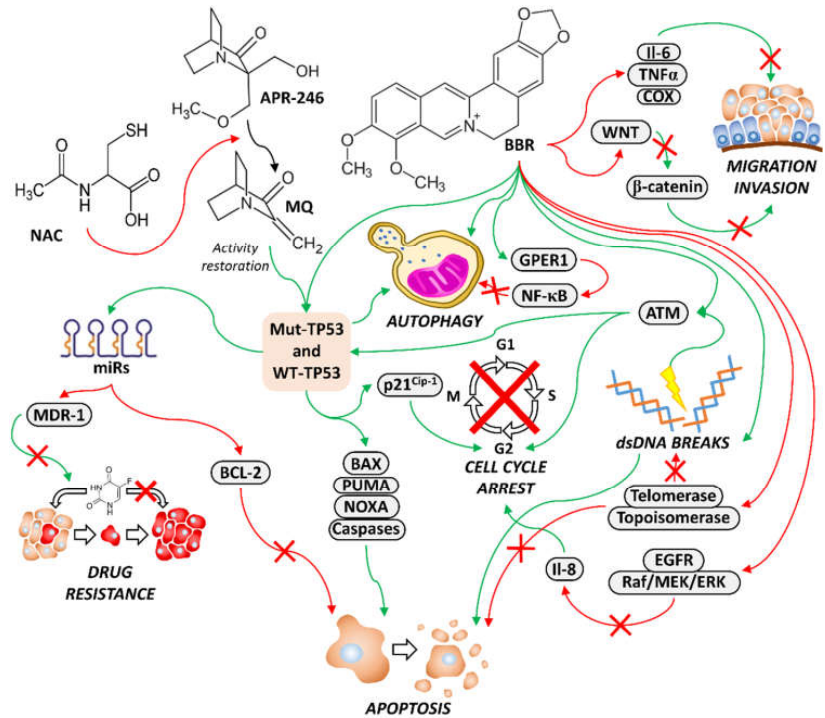
Figure 1. Diagram representing effects of APR-246, BBR and NAX compounds on TP53 activity and cell growth and apoptosis. Restoration of some of the activity of WT TP53 will have effects on expression of miRs, cell cycle regulators and apoptotic molecules. NAC, N-acetylcysteine; APR-246, 2-hydroxymethyl-2-methoxymethyl-3-quinuclidinone; MQ, 2-methylene-3-quinuclidinone; BBR, berberine; Mut-TP53, mutant TP53; green arrows, promote activity; red arrows, block activity; red X in arrow, activity is blocked.